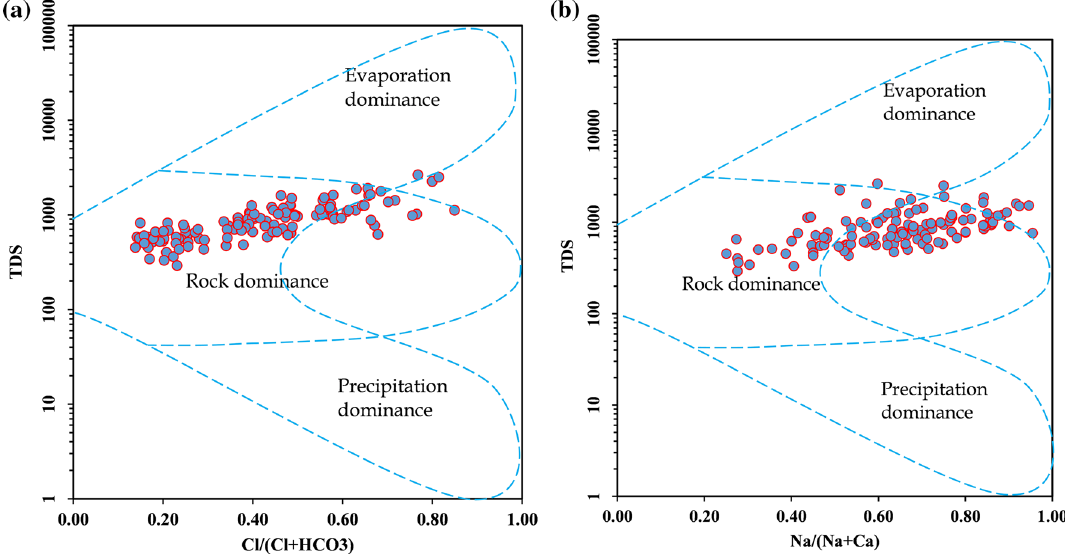
Fig. 10 Gibbs diagram, illustrating the mechanisms controlling the chemistry of groundwater samples from Markapur, Prakasam district, Andhra Pradesh,